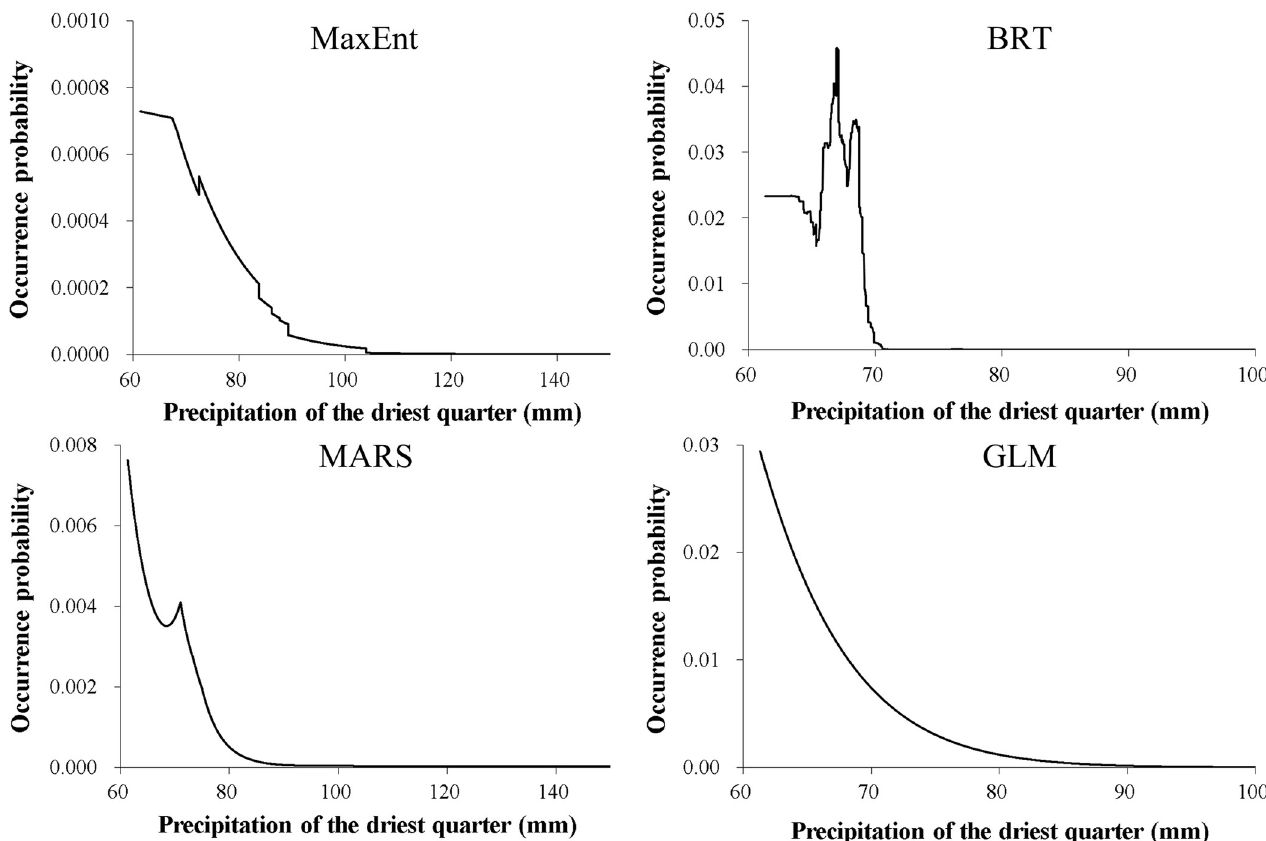
Fig 5. Response curves for the third important predictor, the precipitation of the driest quarter for four of the five species distribution models for nutrias (producing Δ AUC values � 0. 05). MaxEnt = Maximum Entropy; RF = Random Forest; MARS = Multivariate Adaptive Regression Spline; GLM = Generalized Linear Model.